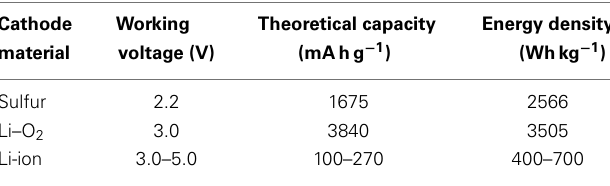
Table 1 |Theoretical capacity, energy density, and working voltage of cathode materials